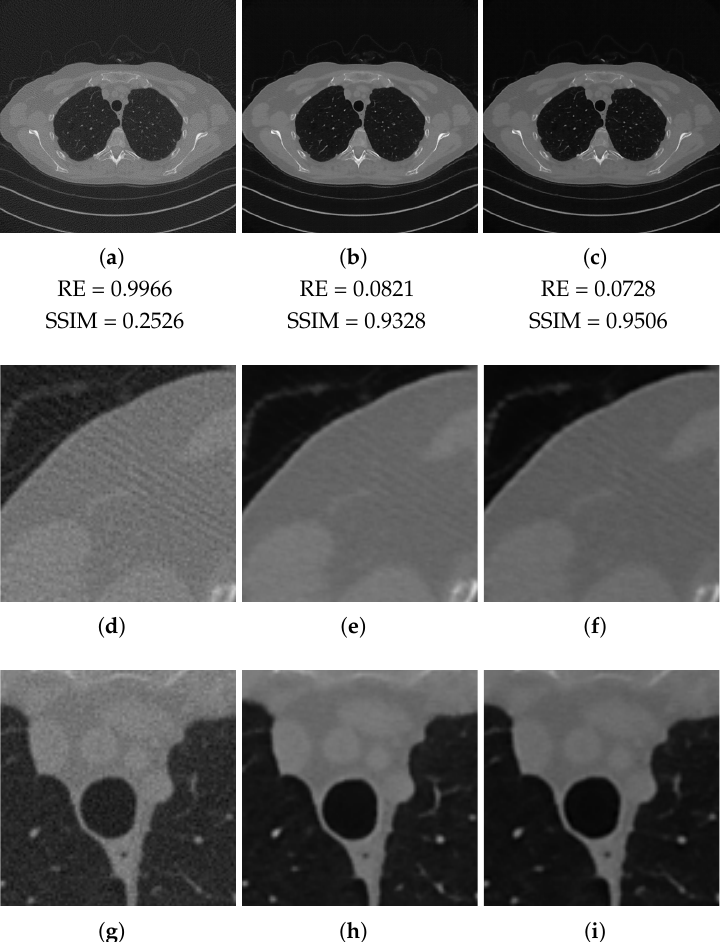
Figure 6. Full-range geometry reconstructions. The results obtained with FPB ( left column ), ResUNet ( central column ) and 3l-SSNet ( right column ). Below each image, the values of its RE and SSIM